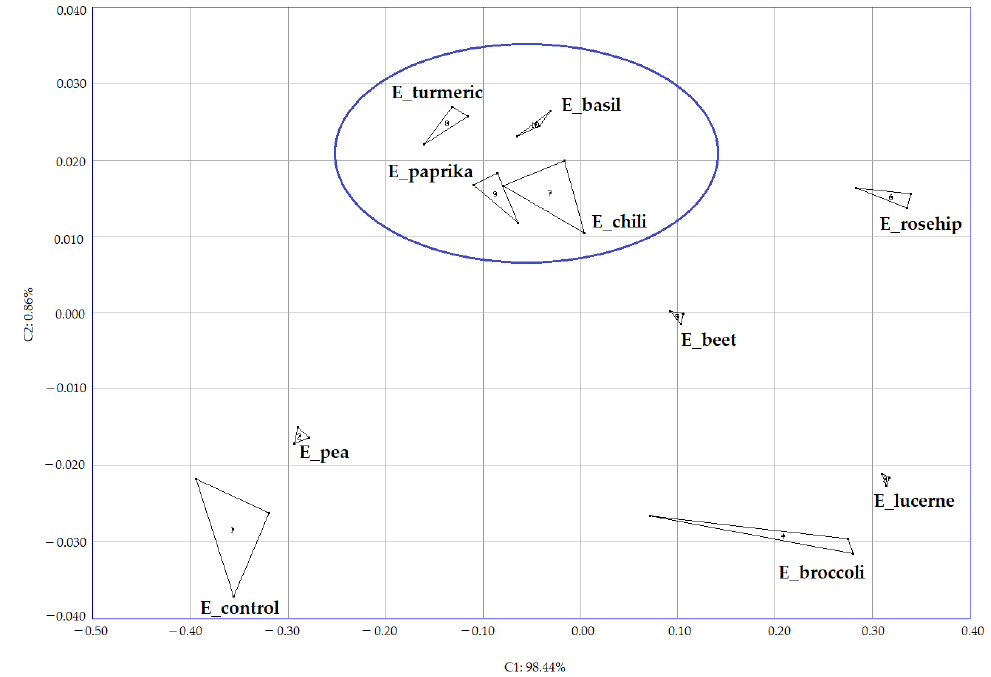
Figure 6. Discrimination of the extrudates based on PCA analysis of overall volatile composition.